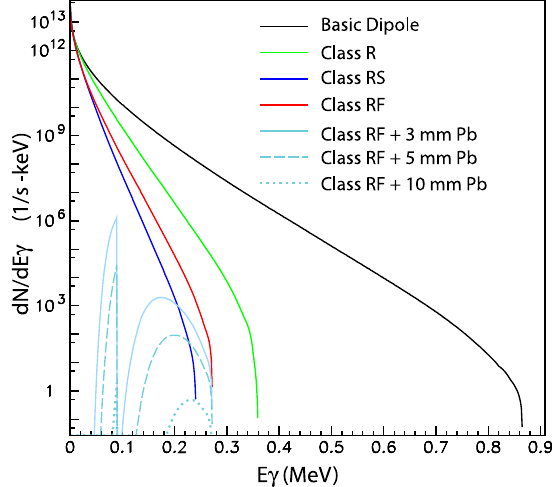
FIG. 7. Synchrotron-radiation spectra from a 100 μ A electron beam for the basic Compton dipole (black) and for an example of each of the three class variations For the Class-RF example, the effects of three thicknesses of lead filters are also shown.